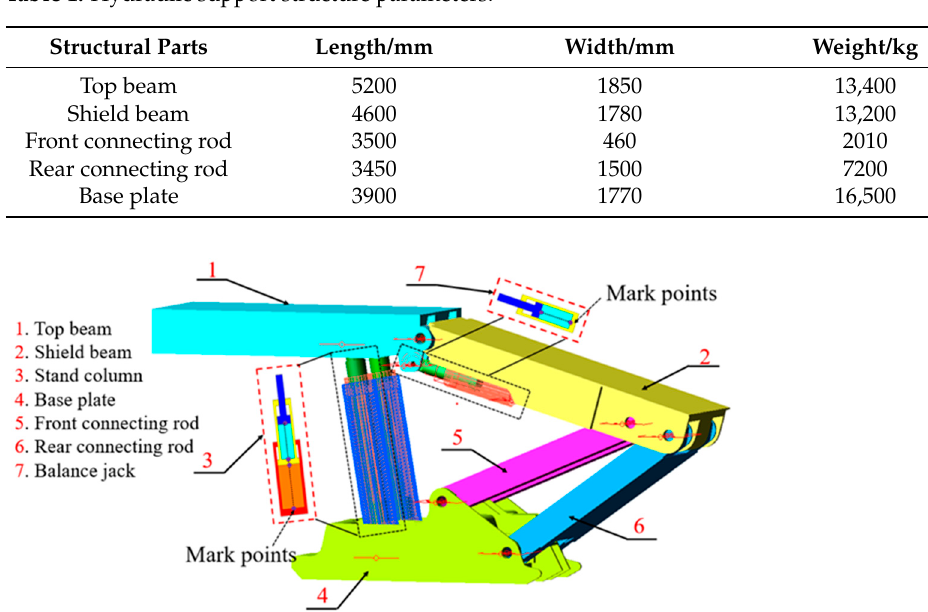
Table 1. Hydraulic support structure parameters.